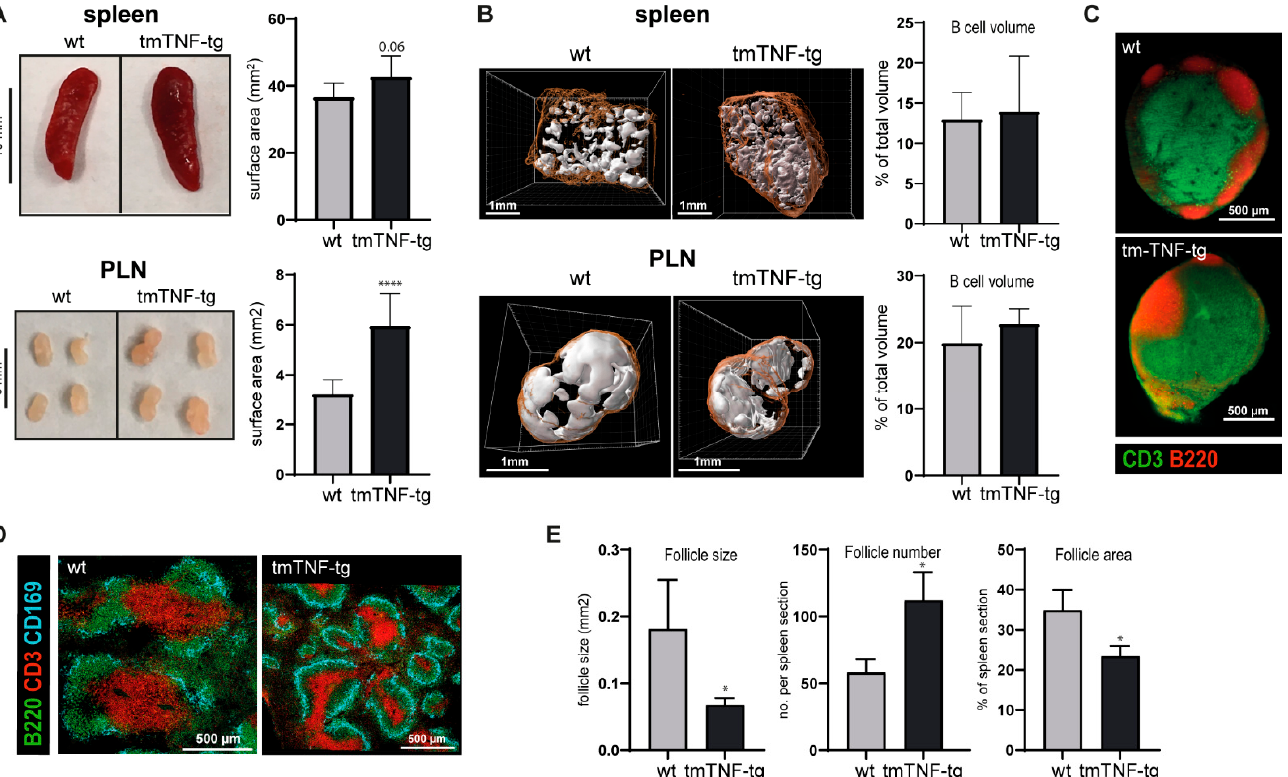
Figure 1. Spleen and lymph nodes of tmTNF-tg mice have enlarged SLOs and abnormal splenic lymphoid follicle structures. Spleen and PLNs were histologically analyzed. ( A ) Representative pictures of the spleen and PLNs of tmTNF-tg and wt mice. SLOs of tmTNF-tg mice are macroscopically enlarged compared to wt mice ( n = 3 PLN; n = 5 spleen). ( B ) Representative three-dimensional reconstructions of whole PLN and spleen sections. Ultramicroscopy analysis revealed no changes in B cell volume of tmTNF-tg SLOs compared to wt ( n = 3; white = B cell areas, orange = tissue outline). ( C ) Immunofluorescent staining indicated that PLNs of tmTNF-tg mice develop normal B cell follicles, representative images. ( D ) Representative image of a spleen of a tmTNF-tg mouse. Splenic lymphoid follicles contained B and T cell areas with defined CD169 + marginal zones (CD3 = marker for T cells; B220 = marker for B cells). ( E ) Spleen of 17-week-old tmTNF-tg mice have a decrease in lymphoid follicles size and follicle area (as percentage of the total surface of the spleen), but an increase in follicle number ( n = 6). (* p ≤ 0.05, **** p ≤ 0.0001).